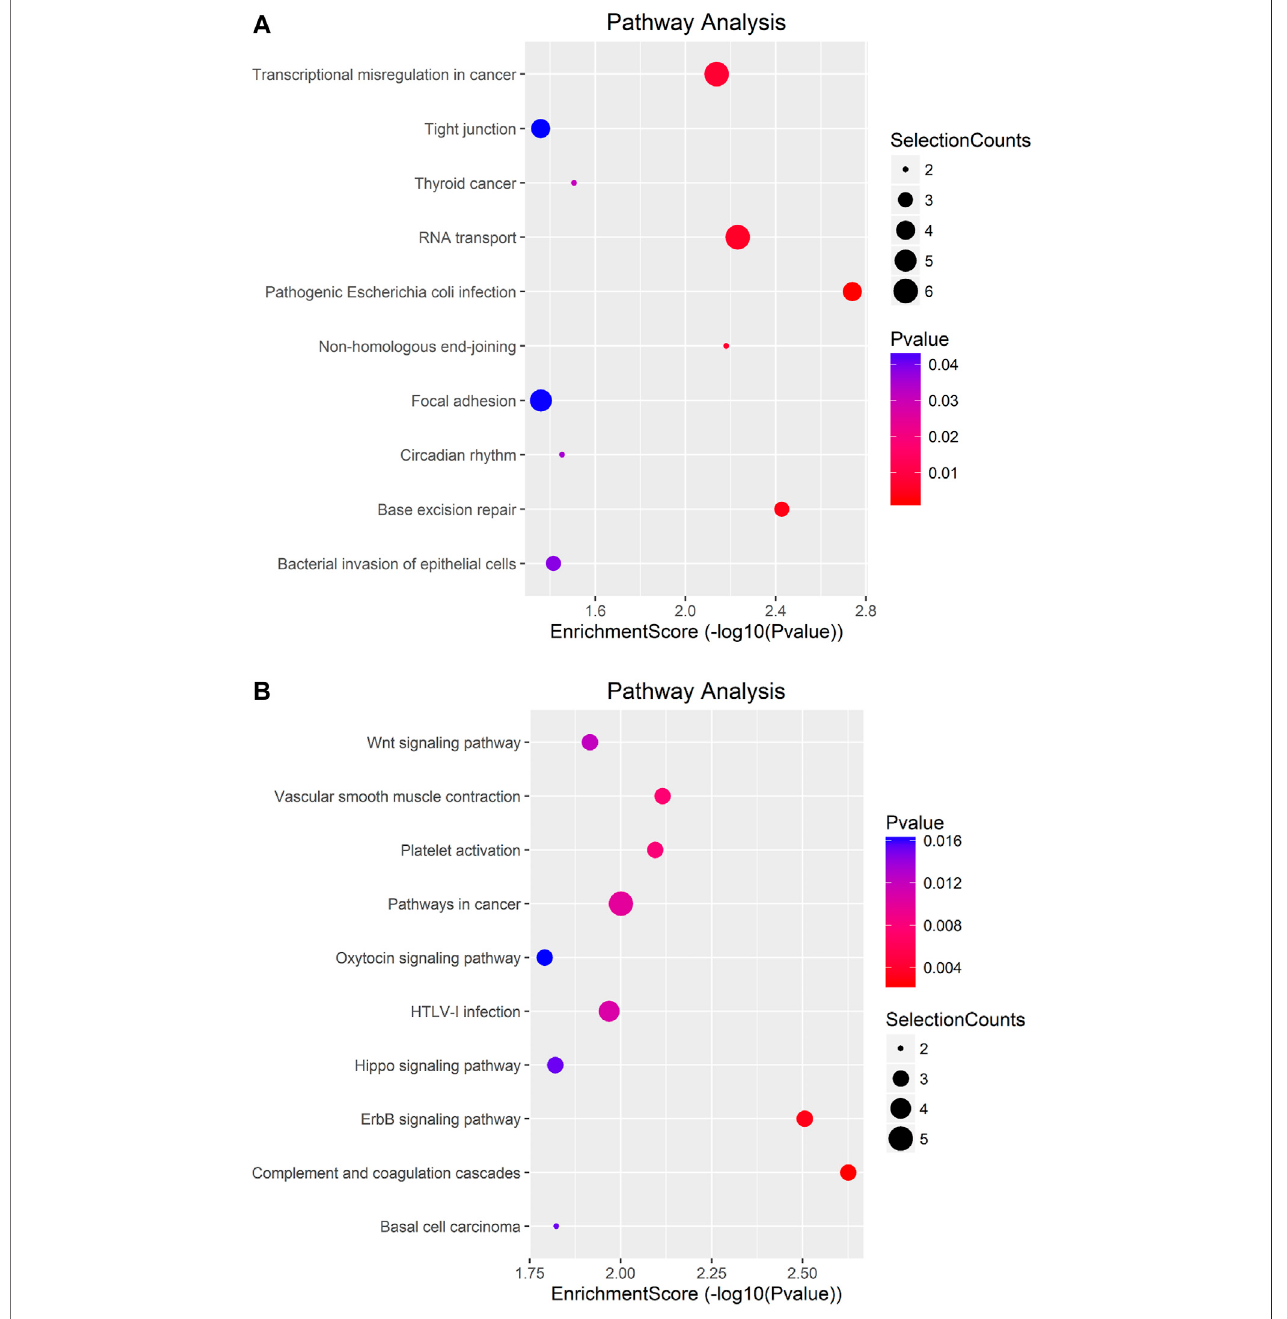
FIGURE6| PathwayanalysisofmRNAsharboringdifferentiallymethylatedN 6 -methyladenosinesites. (A) BubblePlotshowingthetoptenenrichmentscoresofthe signi fi cant enrichment pathway for the hyper-methylated genes. (B) Bubble Plot showing the top ten enrichment scores of the signi fi cant enrichment pathways of the hypo-methylated